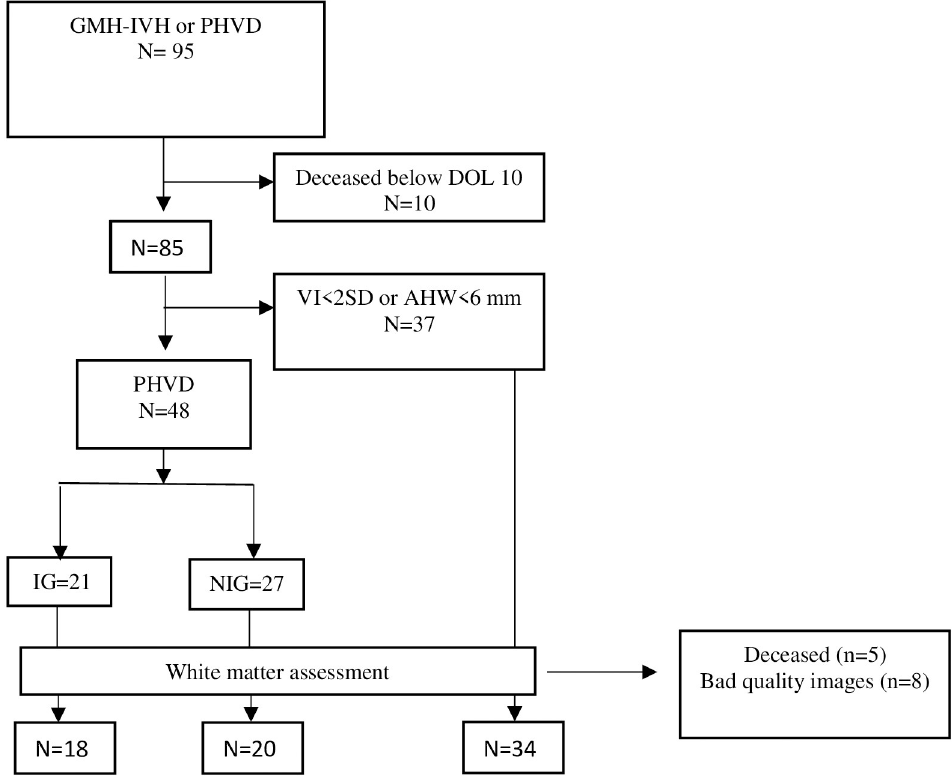
Fig 1. Flow chart of the study population. Flowchart of eligible infants (n = 95) and excluded infants (n = 10 who died before DOL 10 and n = 37 who had no PHVD threshold criteria). Forty-eight infants with PHVD were included in the final analysis. Abbreviations: GMH-IVH, germinal matrix hemorrhage-intraventricular hemorrhage; DOL, day of life; PHVD, post-hemorrhagic ventricular dilatation; VI, ventricular index; AHW, anterior horn width. IG, intervention group; NG, non-intervention